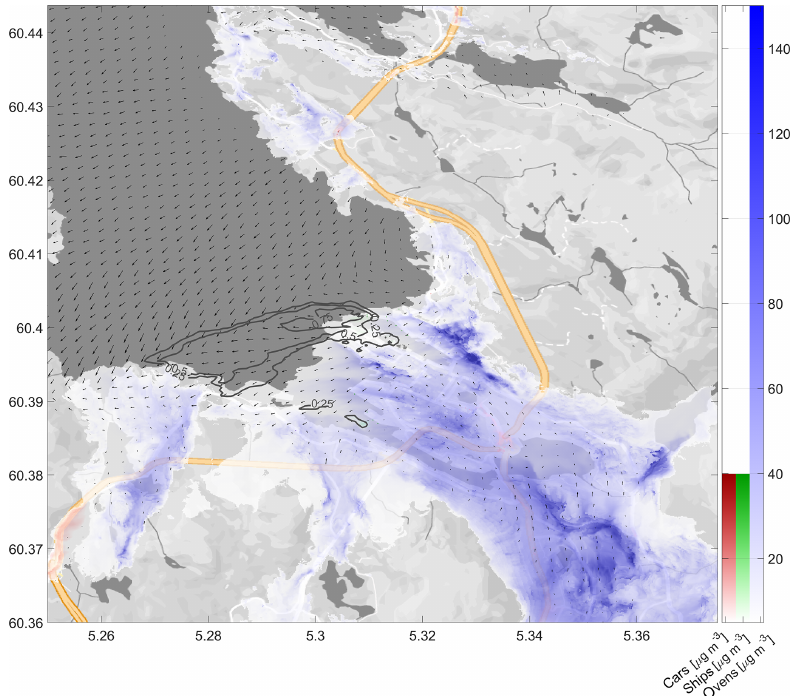
Figure 10. The same as in Fig. 8 but for the scenario ws03_wd02_ft02. The concentrations are given by semi-transparent colour shading overlaying the grayscale land and water surface taken from map data ©2019